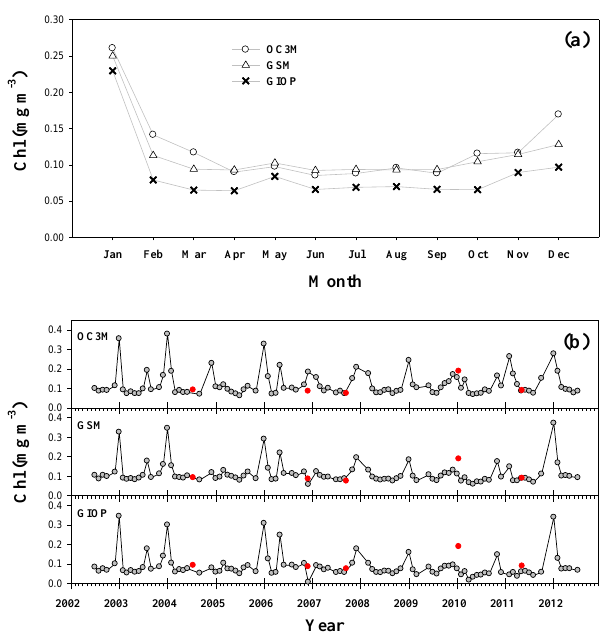
Fig. 5. Monthly climatology (a) and monthly variations (b) of MODIS Chl at SEATS. Red symbols refer to field measured Chl.